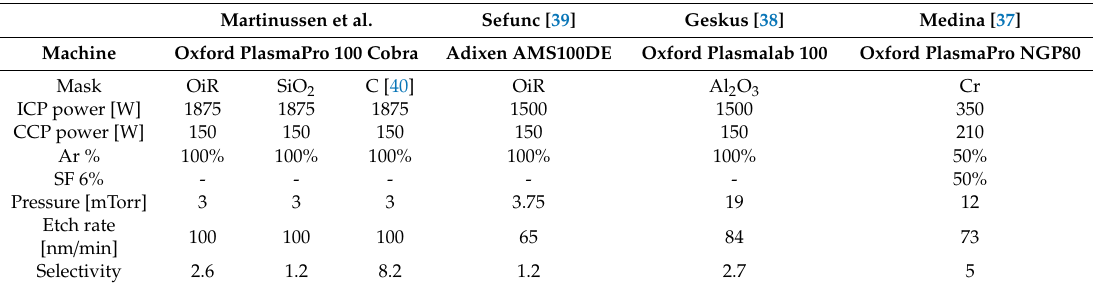
Table 2. Overview of ICP-RIE etching processes used in this work and in previous works, using OiR series photoresists and various hard mask